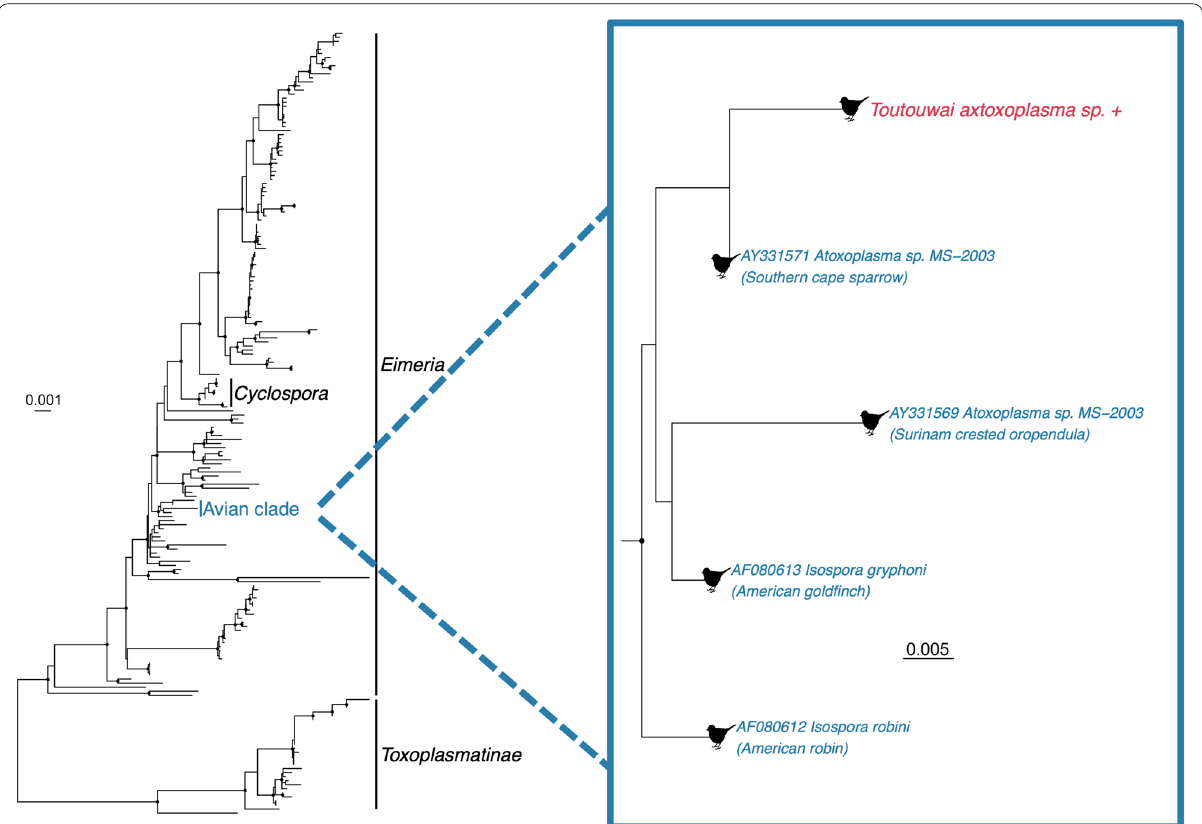
Fig. 6 Phylogeny of the coccidian parasite family Eimeriidae based on the 18S rRNA gene (alignment length of 3084 nucleotides). The coccidium from this study – denoted toutouwai axtoxoplasma sp. - is shown in red and has a ‘ only) is shown in the inset and are marked with a bird silhouette. Black circles on nodes show bootstrap support values of more than 90%. Branches are scaled according to the number of nucleotide substitutions per site, shown in the scale bar. The tree is midpoint rooted for purposes of clarity